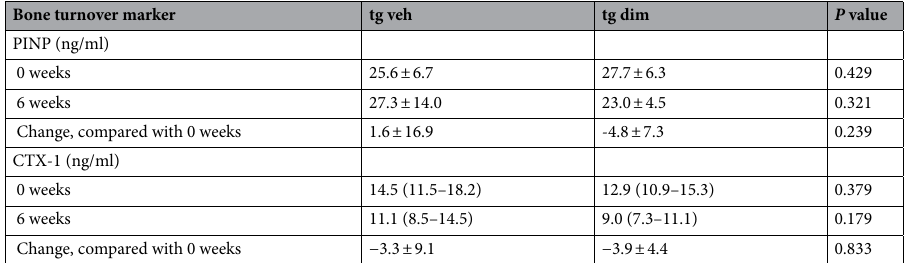
Bone turnover marker tg veh tg